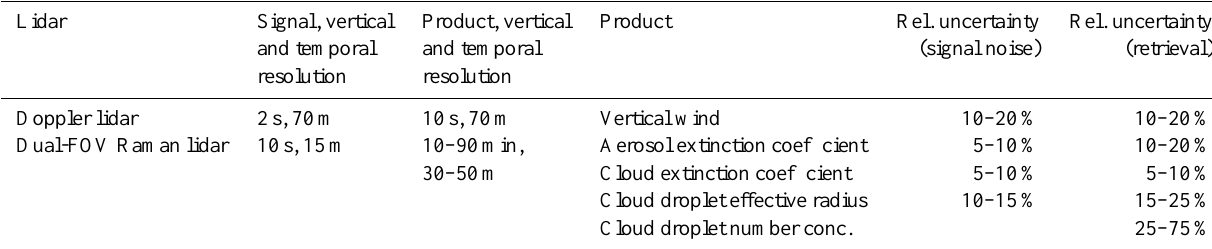
Table 1. Lidar parameters, signal sampling resolution and typical signal averaging periods (used in the retrieval of cloud products), the retrieved aerosol and cloud products, and respective uncertainties in the products. Absolute uncertainty in wind observation is 5–15cms − 1 . Typical errors are given. Doppler lidar and dual-FOV Raman lidar were located within a distance of less than 10m and both lidars were pointing exactly to the